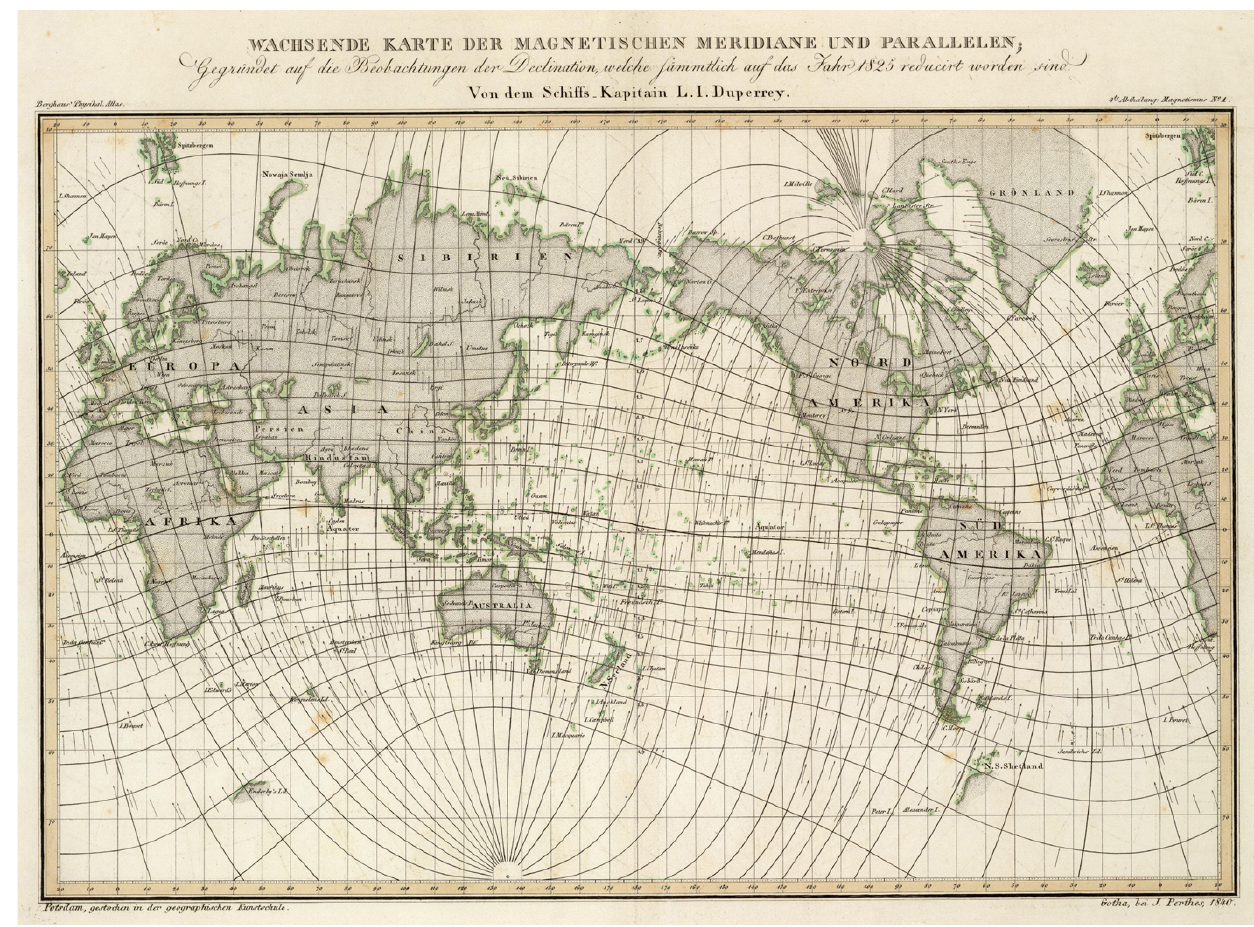
Figure 6. World map of magnetic meridians and parallels measured in 1825 published in Gotha in 1840 (Berghaus, 1837–1848) (David Rumsey Map Collection, www.davidrumsey.com, USA; Images copyright © 2000 by Cartography